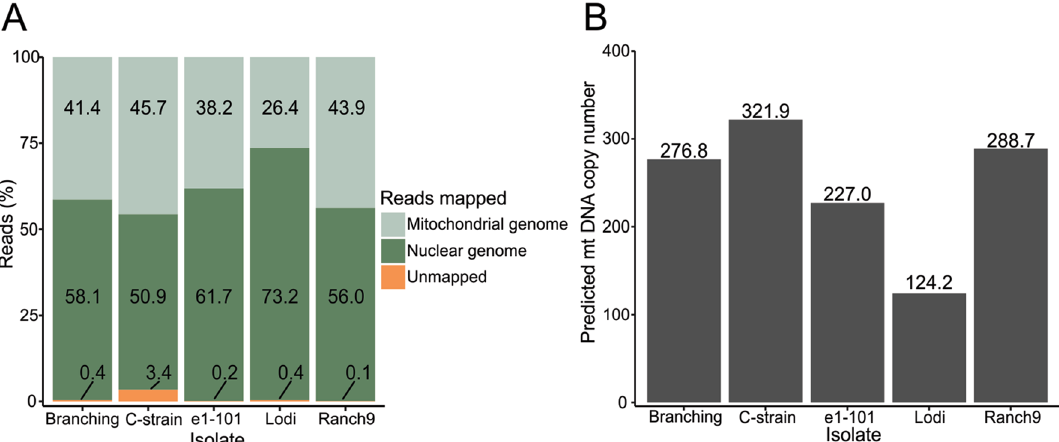
Figure 4. Estimated mitochondrial (mt) DNA copy numbers among isolates of E. necator . ( A ) Bar-plot showing the percentage of whole-genome sequencing (WGS) reads from five E. necator isolates mapped to the nuclear and mt genomes of E. necator C-strain. The large percentage of WGS reads mapped to the mt genome indicates high abundance of mt DNA compared to nuclear DNA. ( B ) Box-plot showing the estimated mt genome copy number per cell for the analyzed isolates. Mt genome copy number was calculated based on the ratio between the mt genome coverage and the nuclear genome